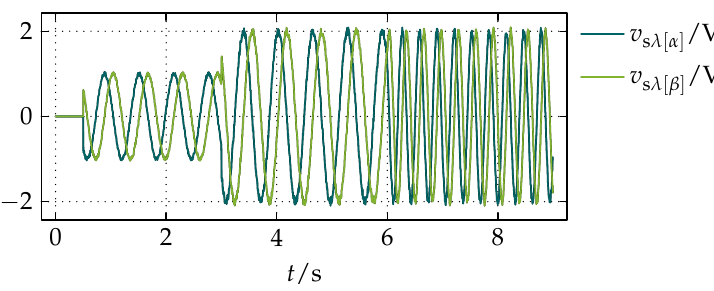
Figure 13. The reference waveforms of v s λ [ α ] and v s λ [ β ] used as noisy test signals for a simulation with